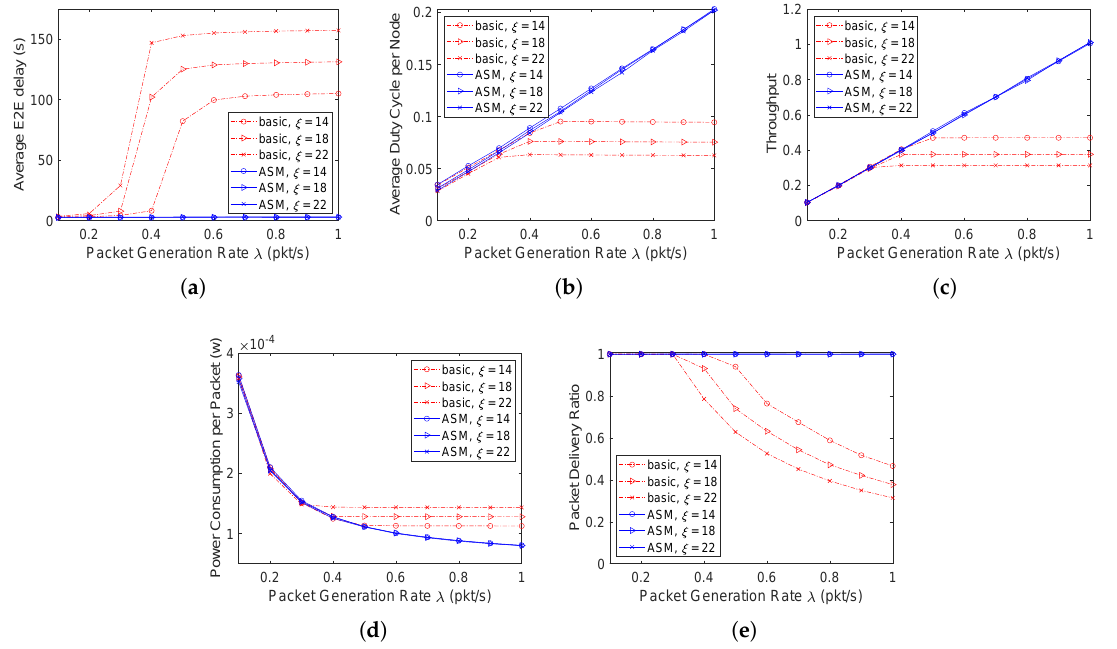
Figure 7. Performance evaluation in the single-chain network scenario. ( a ) Average E2E delay. ( b ) Average duty cycle. ( c ) Throughput. ( d ) Average power consumption. ( e ) Packet delivery